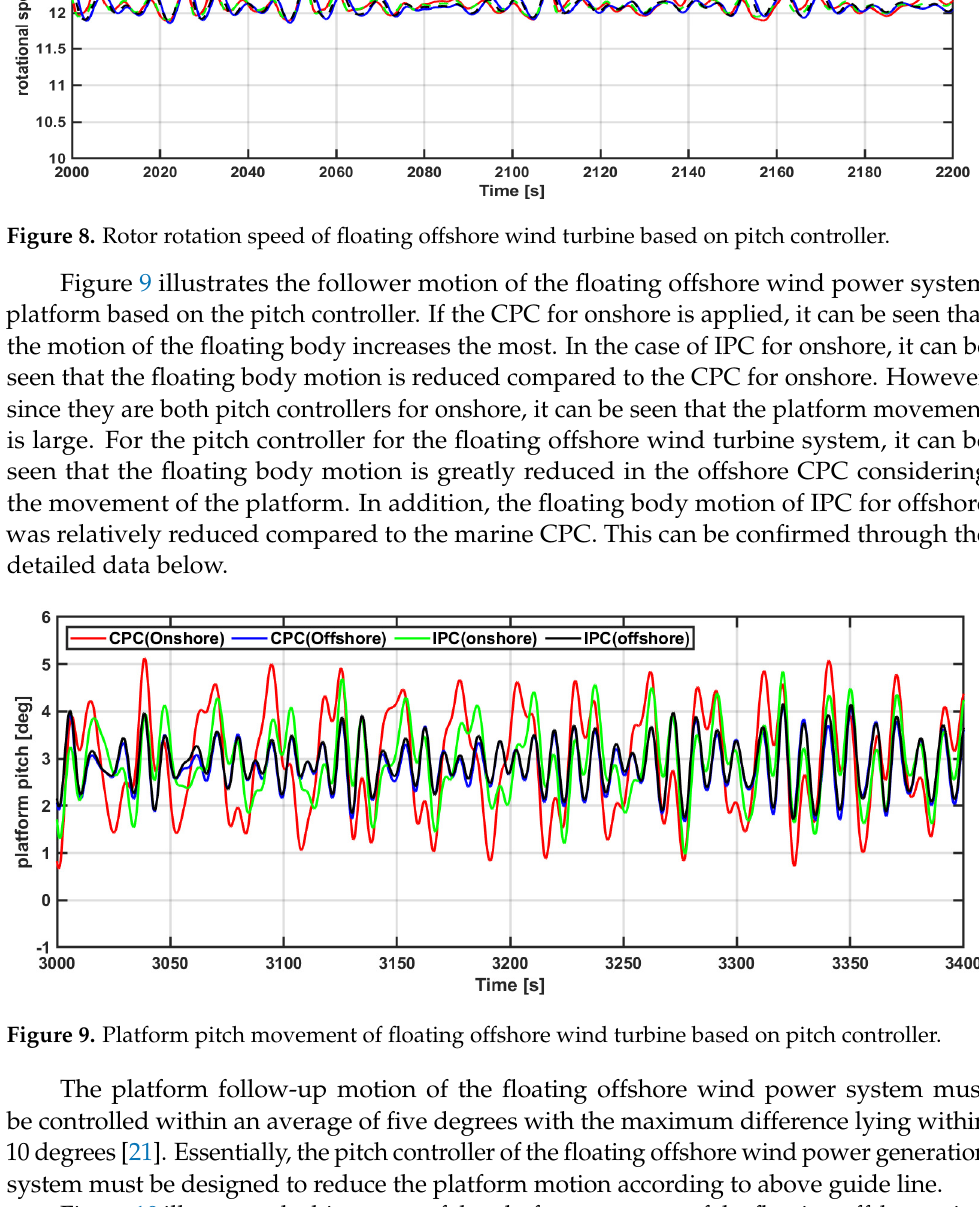
Figure 7. Output characteristics and blade pitch angle of floating offshore wind turbine based on pitch controller.